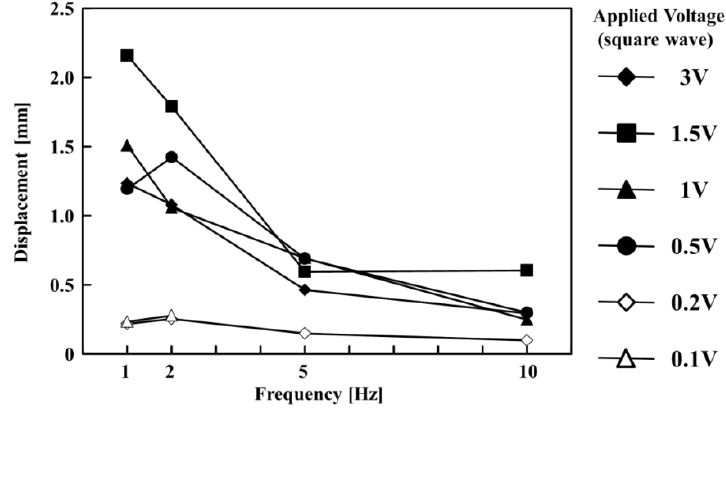
Figure 4. Relationship between frequency and displacement of the paper actuator at different applied voltages (0.1, 0.2, 0.5, 1, 1.5, and 3